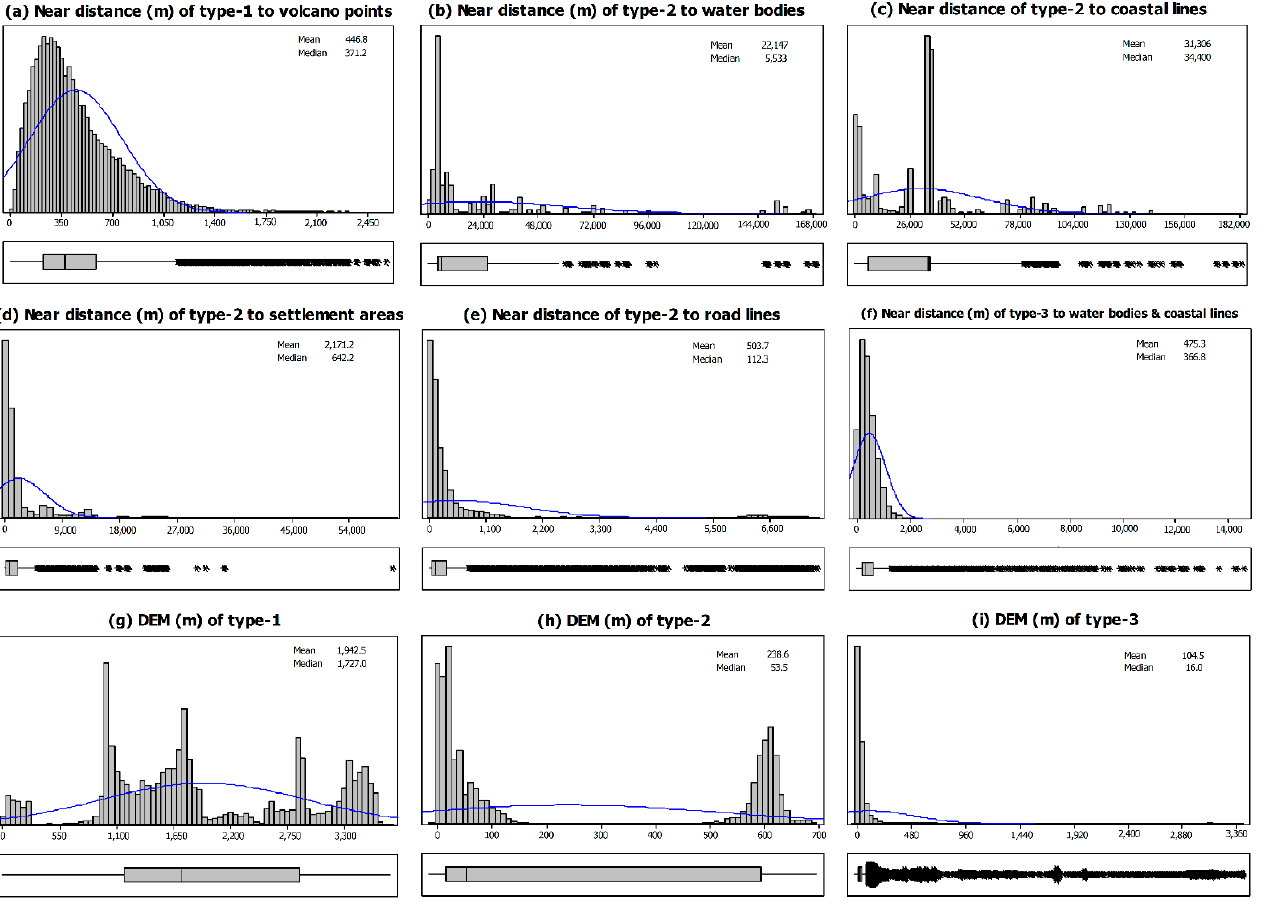
Figure 4. The histogram of estimated near-distance values (m) from the points location of type-1, type-2, and type-3 VNP14IMGML to the geographical features ( a – i ) and the histogram of extracted DEM-SRTM values on type-1, type-2, and type-3 VNP14IMGML ( g – i ). Some examples of other thermal anomalies of biomass burning from VNP14IMGML data (type-1, type-2, and type-3) overlaid on high-spatial-resolution images are shown in Figure 5. Most thermal anomalies are permanent hot objects such as active volcanoes, industrial areas with bright rooftops and chimneys, open mining areas, and industrial gas flares. Meanwhile, false detection over water or offshore and open land close to the coastal zones might depend on the variance of local surface temperature and the effect of sun-glint. However, the detection of these objects can be categorized as false positives for biomass burning because there is no vegetated area over these objects.